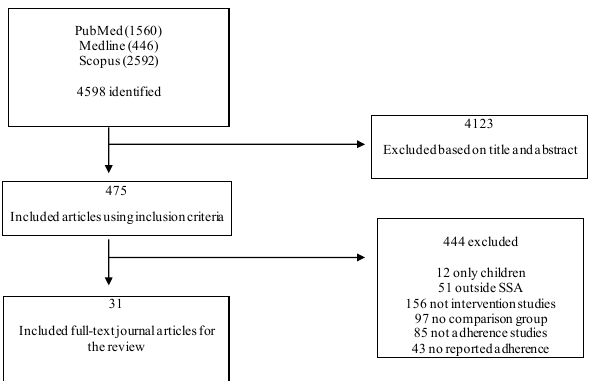
Figure 1. Flowchart of the systematic review according to PRISMA guidelines 2009.